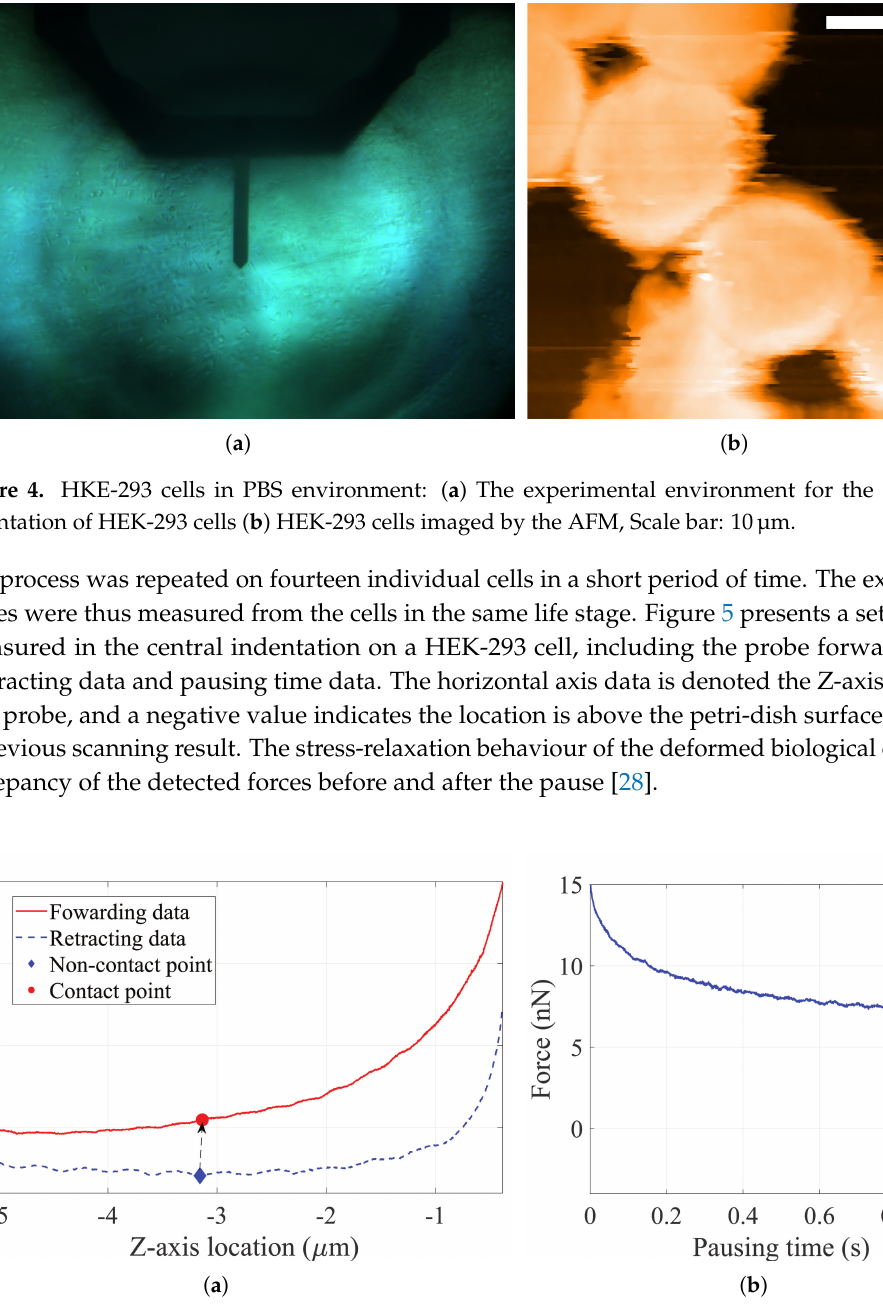
Figure 5. Original experimental data in the central indentation on a HEK-293 cell measured by the AFM: ( a ) the forwarding data and the retracting data ( b ) the pausing time